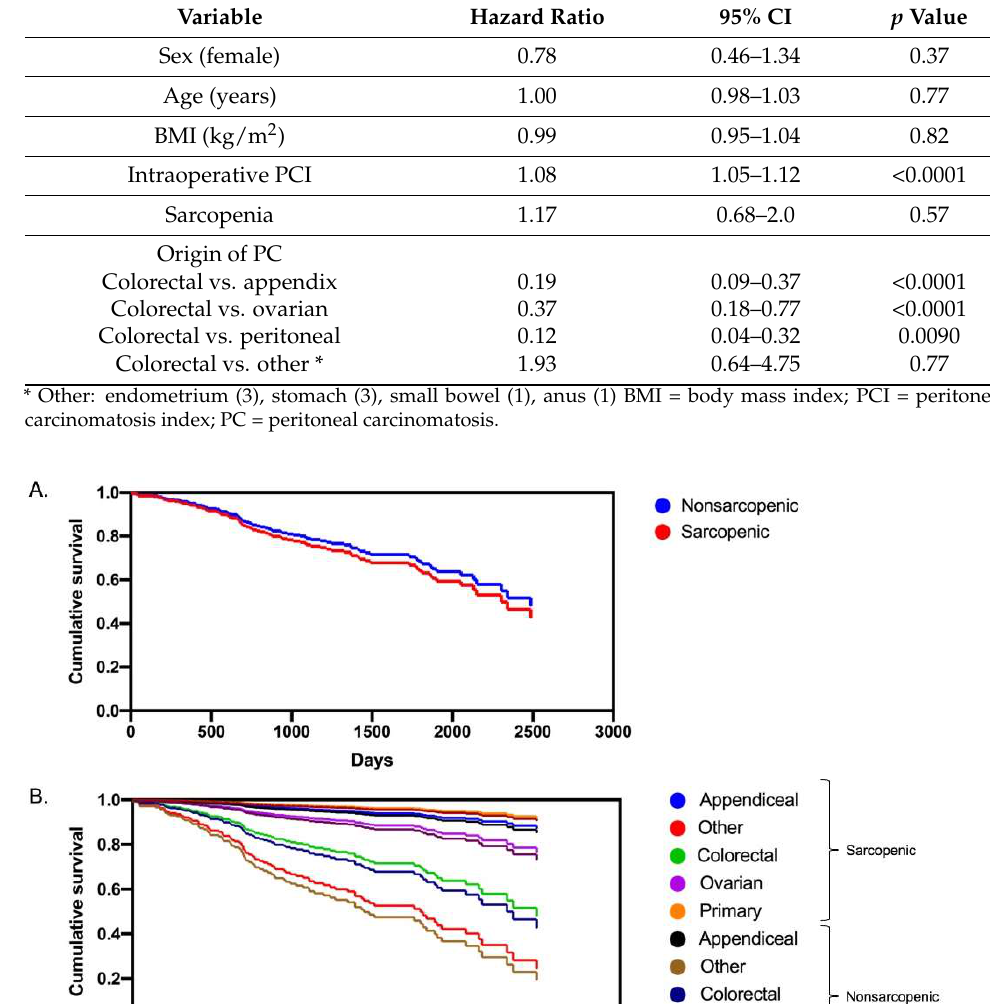
7 Table 3. Multivariate Regression Evaluating 90-day Severe Complications . Variable